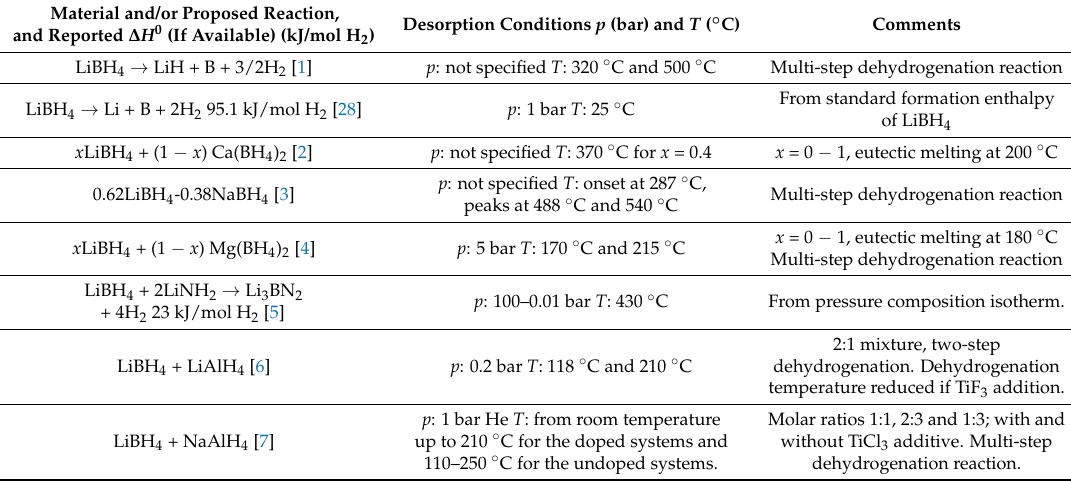
Table 1. Reported hydrogen desorption conditions for several LiBH 4